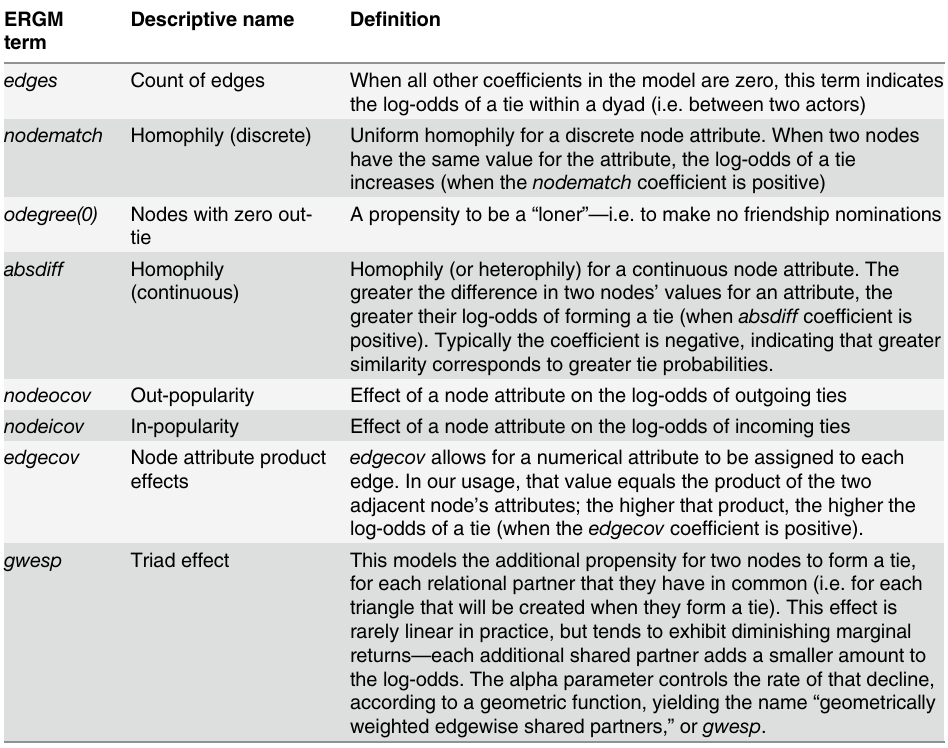
Table 5. ERGM terms, with descriptive names and brief